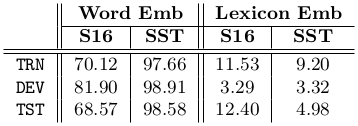
Table from the paper: Lexicon Integrated CNN Models with Attention for Sentiment Analysis
Table text:
WordEmb
LexiconEmb
S16
SST
S16
SST
TRN
70.12
97.66
11.53
9.20
DEV
81.90
98.91
3.29
3.32
TST
68.57
98.58
12.40
4.98